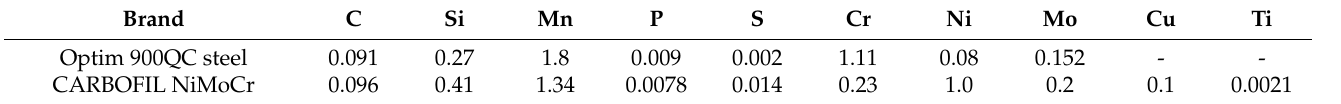
Table 1. Chemical compositions of the base metal and welding wire (in